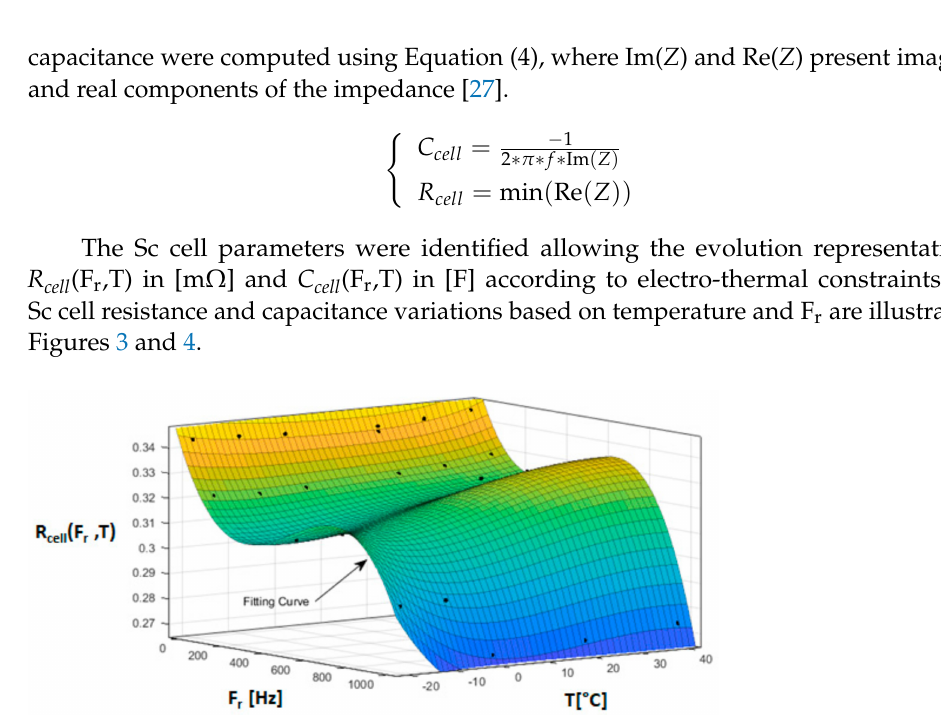
Figure 3. Supercapacitors (Sc) resistance as function of the temperature and DC-current ripples frequency Fr in [Hz] for 500 cycles.